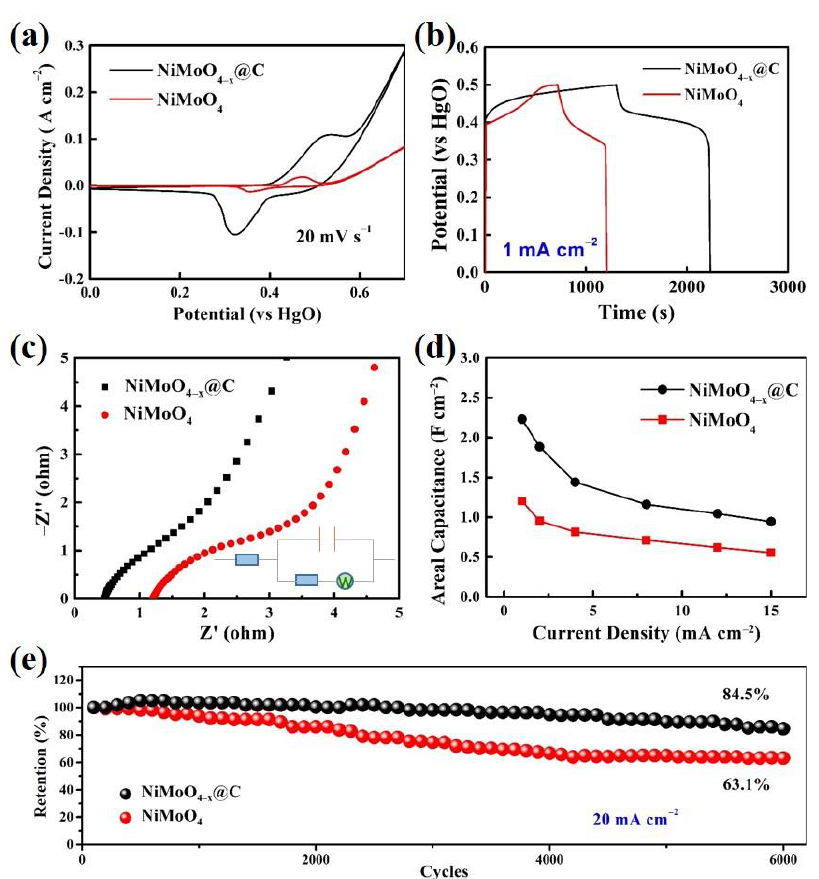
Figure 7. ( a ) CV curves of the NiMoO 4 NWAs and NiMoO 4− x @C at a scan rate of 20 mV s −1 . ( b ) GCD curves and ( c ) EIS spectra of NiMoO 4 NWAs and NiMoO 4− x @C and its corresponding equivalent fitting circuit. ( d ) GCD test of NiMoO 4− x @C at different current densities. ( e ) Cycle test of NiMoO 4 NWAs and NiMoO 4− x @C at 20 mA cm −2 over 6000 cycles.